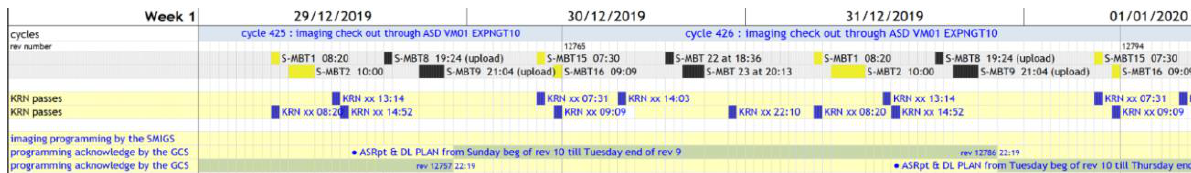
Figure 37. Example of a VM01 programming sequence.